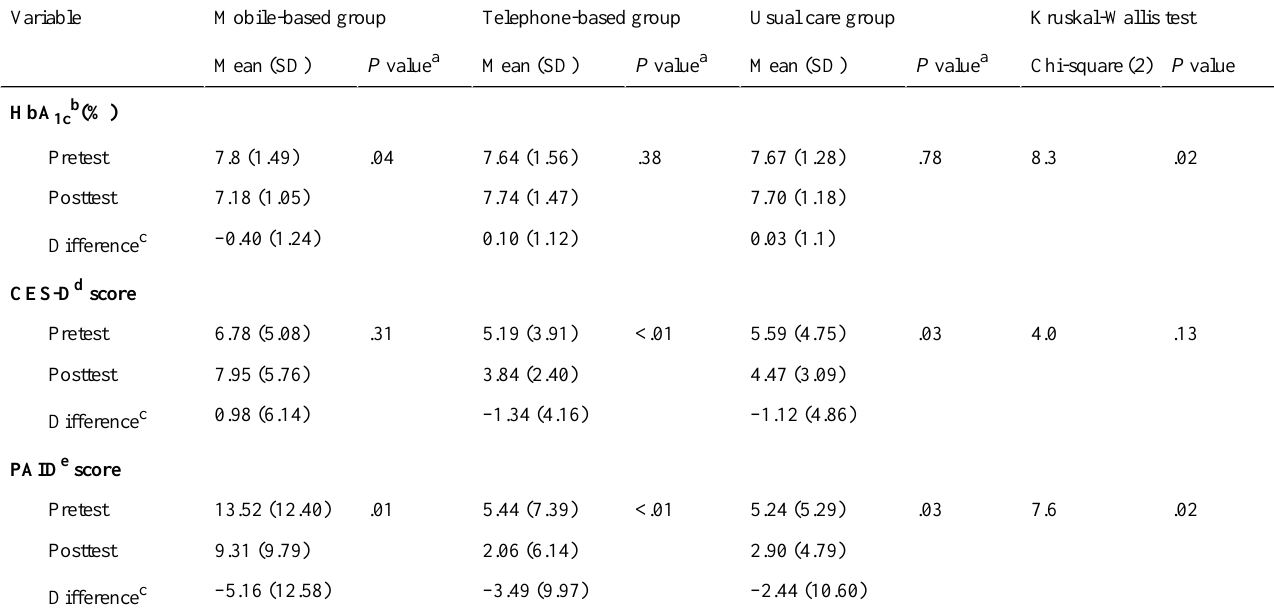
Table 2. Pretest and posttest HbA 1c , CES-D, and PAID scores across the 3 groups and the differences between them.